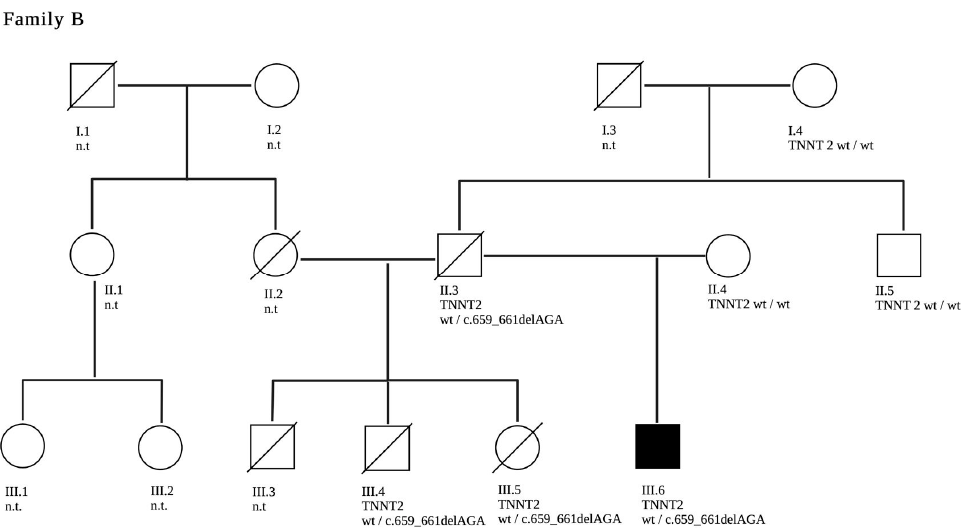
Figure 3. A three-generation family tree of family B is shown. The index patient is B.III.6. The clinically affected patients are marked in black. Deceased are B.II.3, B.III.3 and B.III.4. The c.659_661delAGA pathogenic variant in TNNT2 segregated with disease in the genotyped individuals. Family members who have not been genetically tested are labelled n.t—“not tested”.